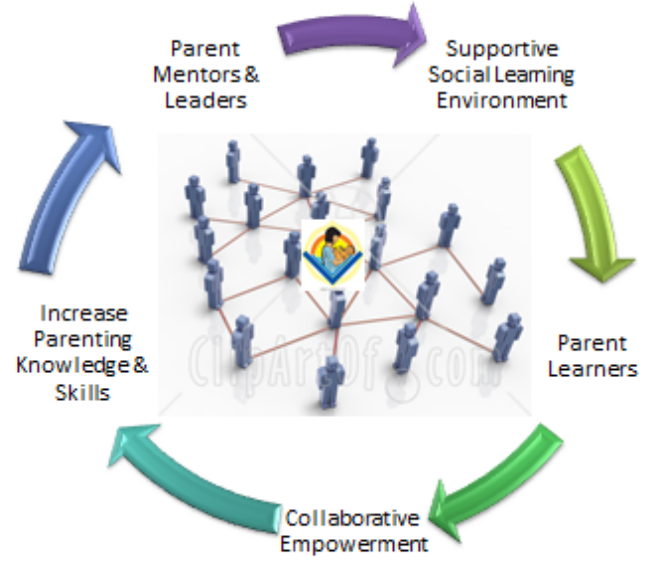
Figure 1. Improving parenting through